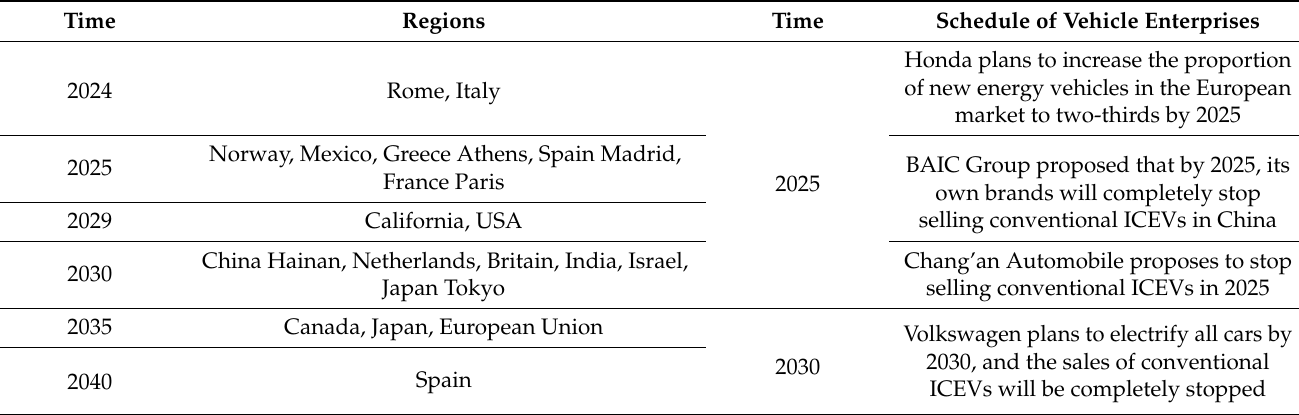
Table 1. Time Schedule for Prohibiting the Sale of ICEVs in Different Regions/Time Schedule for Stopping the Sale of ICEVs by Different Vehicle